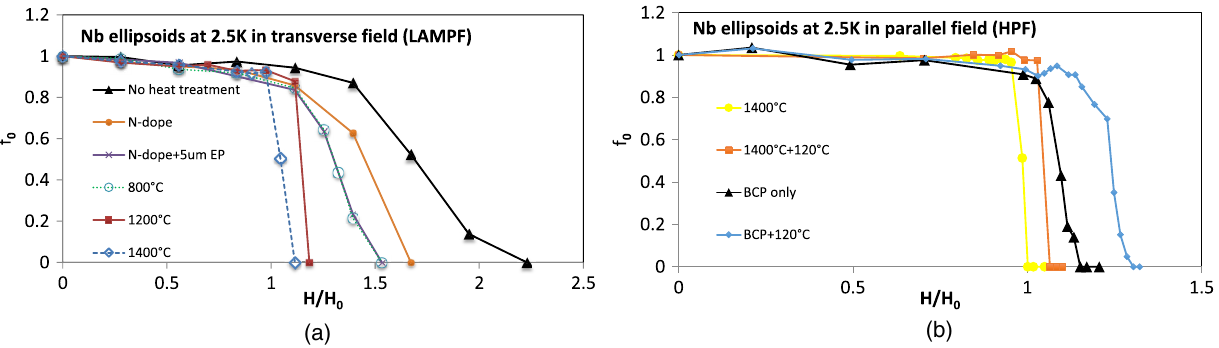
FIG. 13. Fit parameter f 0 signifying the volume fraction probed by the muons which is in the field free Meissner state as a function of applied field for ellipsoid samples with different heat treatments measured in (a) the LAMPF spectrometer and (b) the HPF